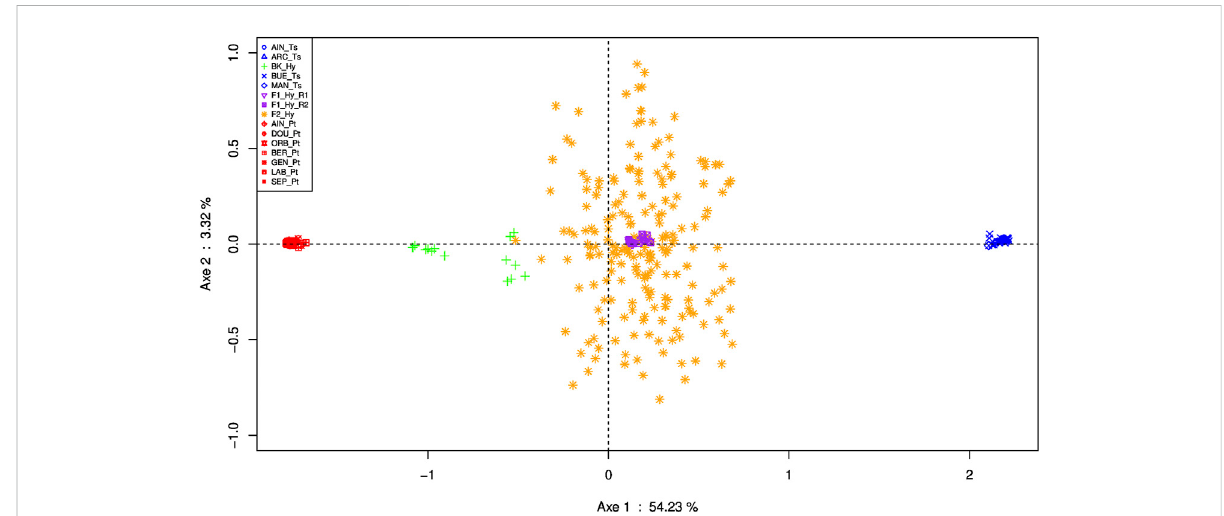
FIGURE 6 Specimen representation on the main PCA plane performed on SNP discriminant data, with standardization as proposed by (Patterson et al., 2006). In red, P. toxostoma populations (AIN_Pt for Ain River, DOU_Pt for Doubs River, ORB_Pt for Orbieu River, BER_Pt for Berre River, GEN_Pt for genitors, LAB_Pt for laboratory specimens, SEP_Pt for Serre-Ponçon Lake); in blue, T. souf fi a populations (AIN_Ts for the Ain River, ARC_Ts for the Archidiacre site in Durance River, BUE_Ts for the Buech River, MAN_Ts for Manosque on the Durance River); in purple, F1_Hy_R1 for the fi rst series of F1 laboratory samples, and F1_Hy_R2 for the second series of F1 laboratory samples; in orange, F2_Hy for F2 samples; in green, BK_Hy for laboratory samples backcrossed between F1 and P. toxostoma